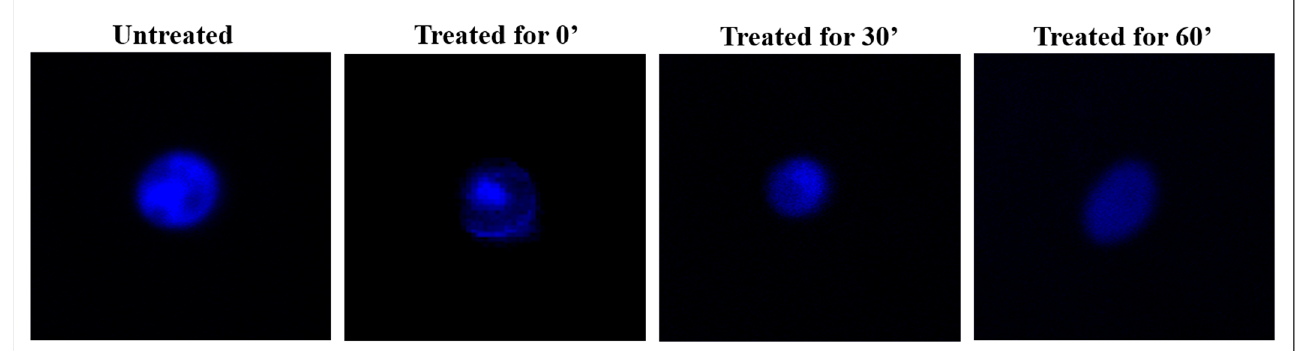
Figure 5. Confocal laser scanning microscopy of C. albicans 1/18 clinical isolate exposed for up to 60 ′ to the distilled extract of bergamot. DAPI staining for DNA identification was performed. “Untreated”: growth control of C. albicans 1/18 ; “treated”: C. albicans 1/18 treated with the distilled extract of bergamot.